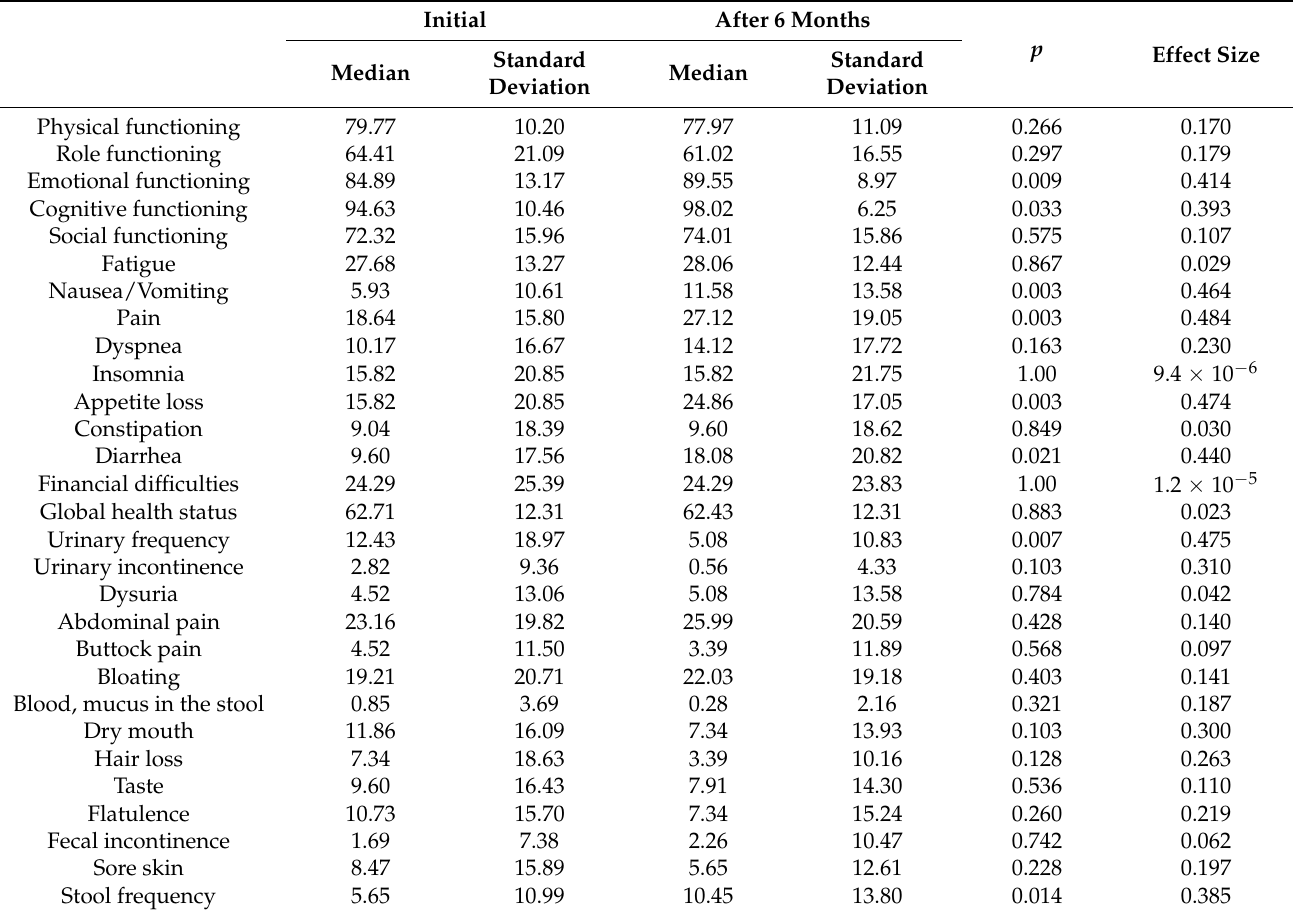
Table 2. Quality of life at baseline and after 6 months of treatment according to EORTC QLQ-C30 and EORTC